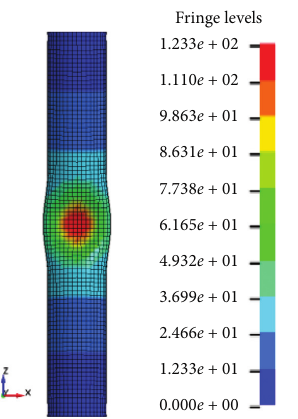
Figure 12: Simulation result for NSS CFST column (scaled distance � 0.14m/kg 1/3 ).